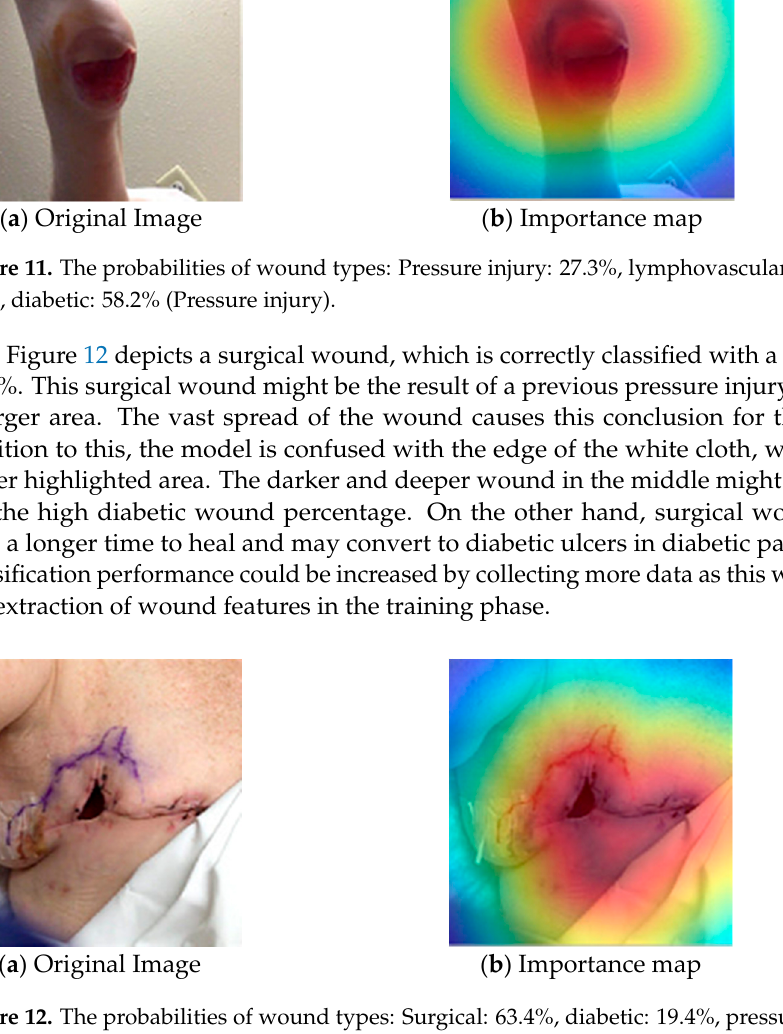
lymphovascular: 2.2%